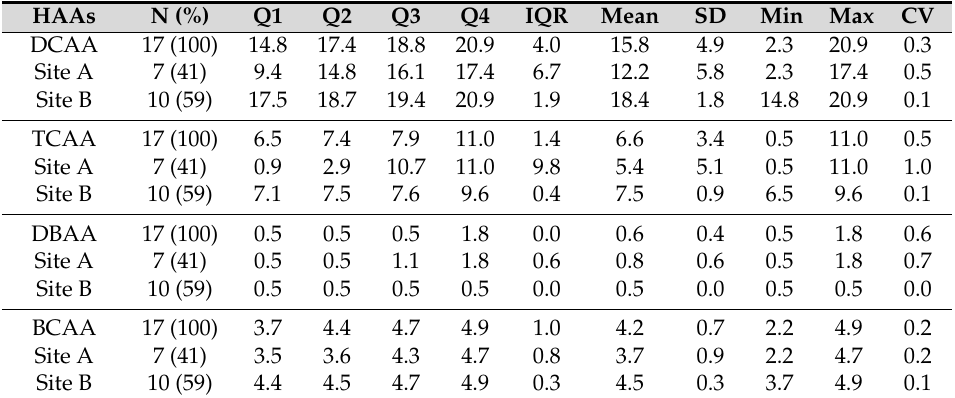
Table 3. Measured concentrations (in µ g/L) of HAAs in water